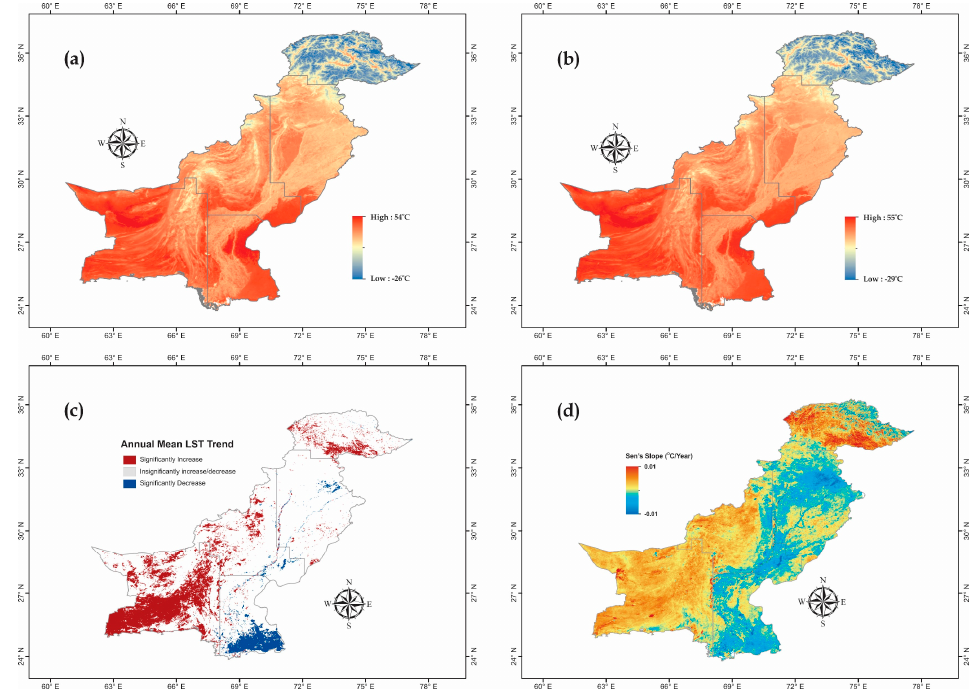
Figure 11. The spatial distribution of the mean LSTs and trend variables. ( a ) Annual LST in 2005, ( b ) annual LST in 2018, ( c , d ) significant increase and decrease along with Sen’s slope from 2005 to 2018. The greatest interannual differences were found in regions I, II, and V. In contrast,